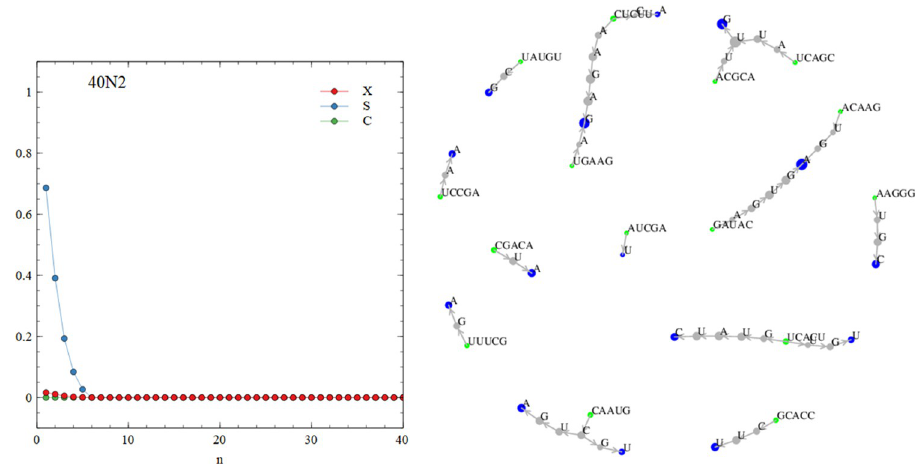
Fig 9. The graph functions and word graph for run 40N2 shows disconnected elements with no cycles.